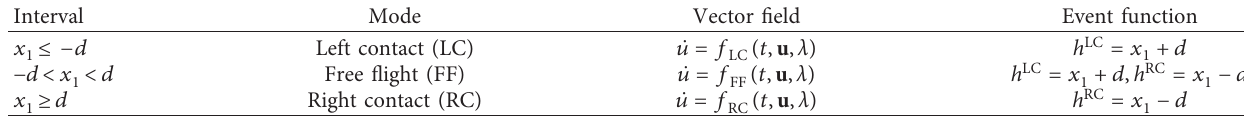
Table 1: The modes, vector fields, and event functions used for numerical simulation in COCO.